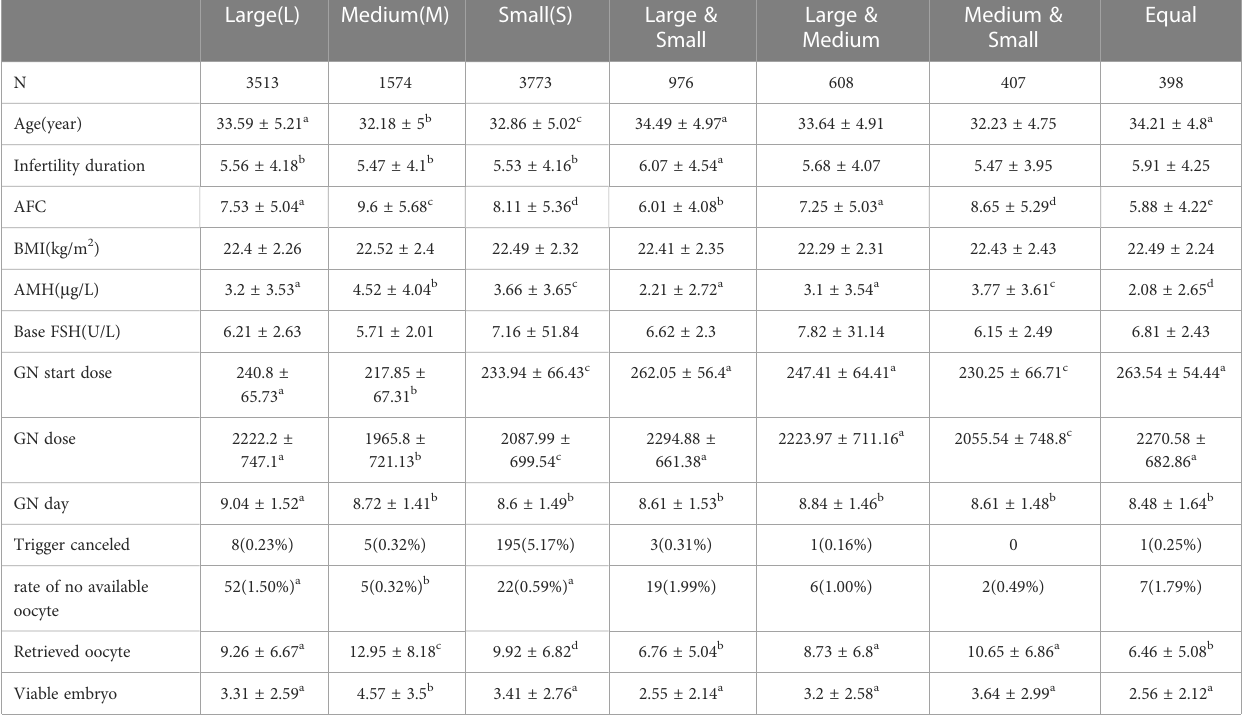
TABLE 1 Characteristics of patients receiving IVF treatment. Large(L) Medium(M)